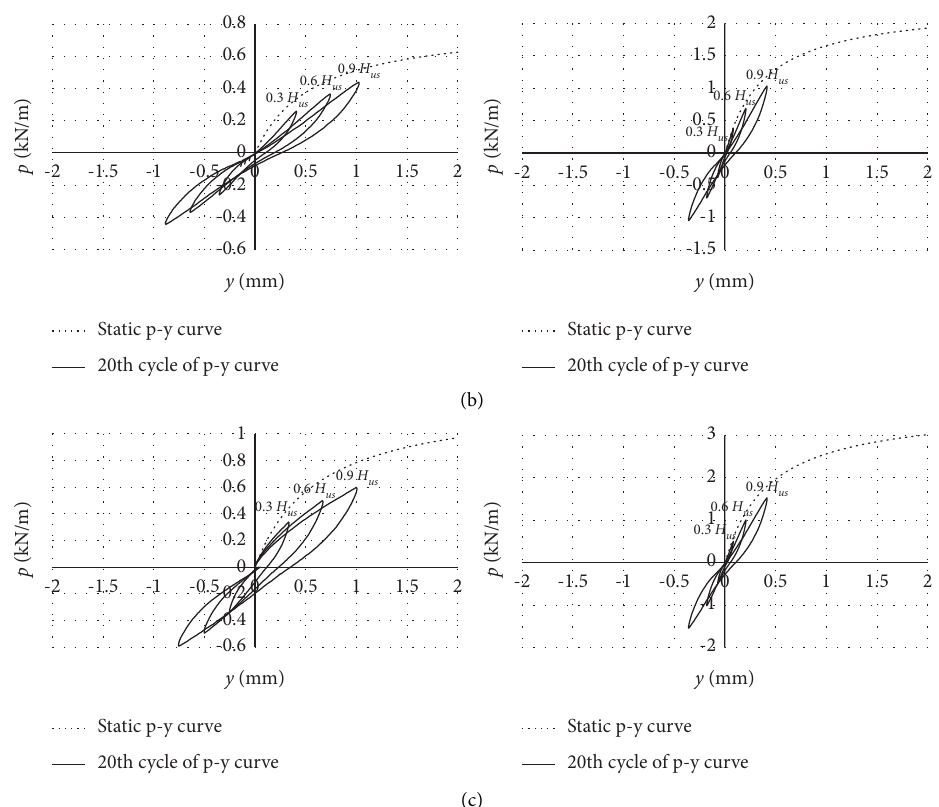
Figure 9: Comparison between 20 th cycle of p - y curves and experimental static p - y curves at depths of 2 D (left) and 6 D (right). (a) 40%. (b) 70%. (c) 90%.